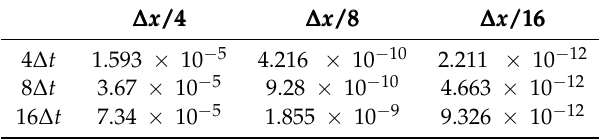
Table 1. Convergence tableau for the ABA-splitting